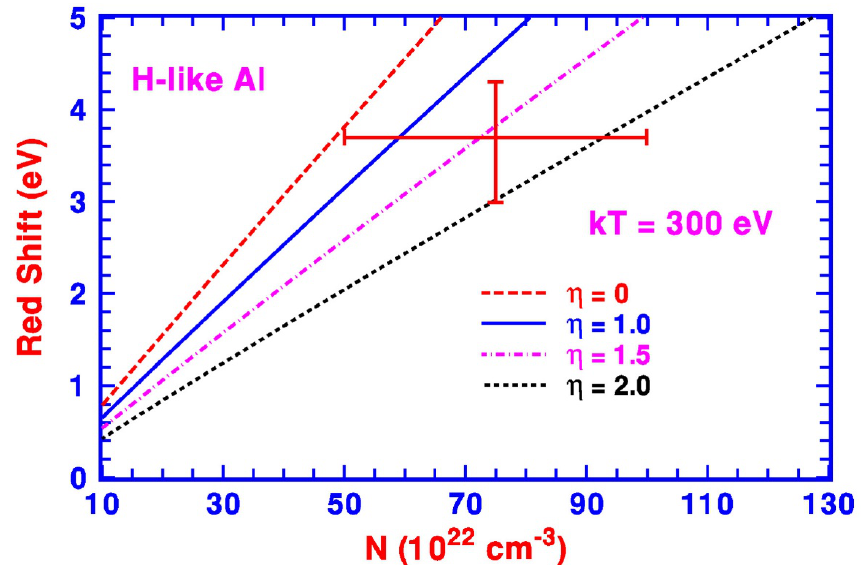
Figure 1. Comparison between the experimentally measured Lyman- α redshift of the H-like Al ion [36] with the theoretical estimations with the radius of the Debye sphere A in terms the size parameters η = 0, 1, 1.5, and